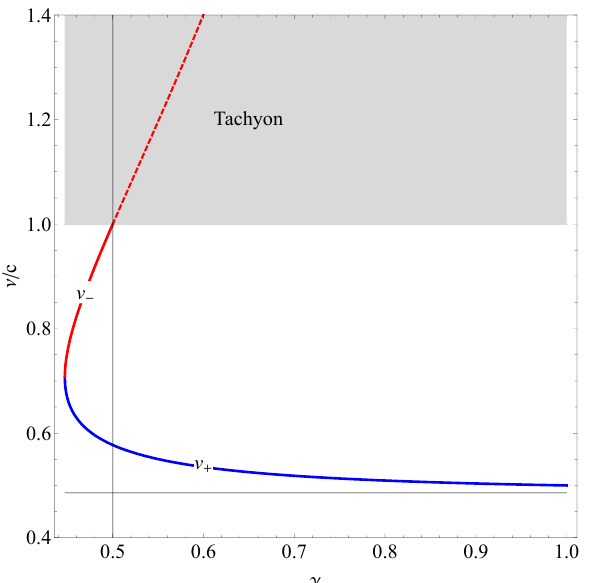
Figure 1. The orbital velocity of particle at the closest stable orbit as functions of the γ